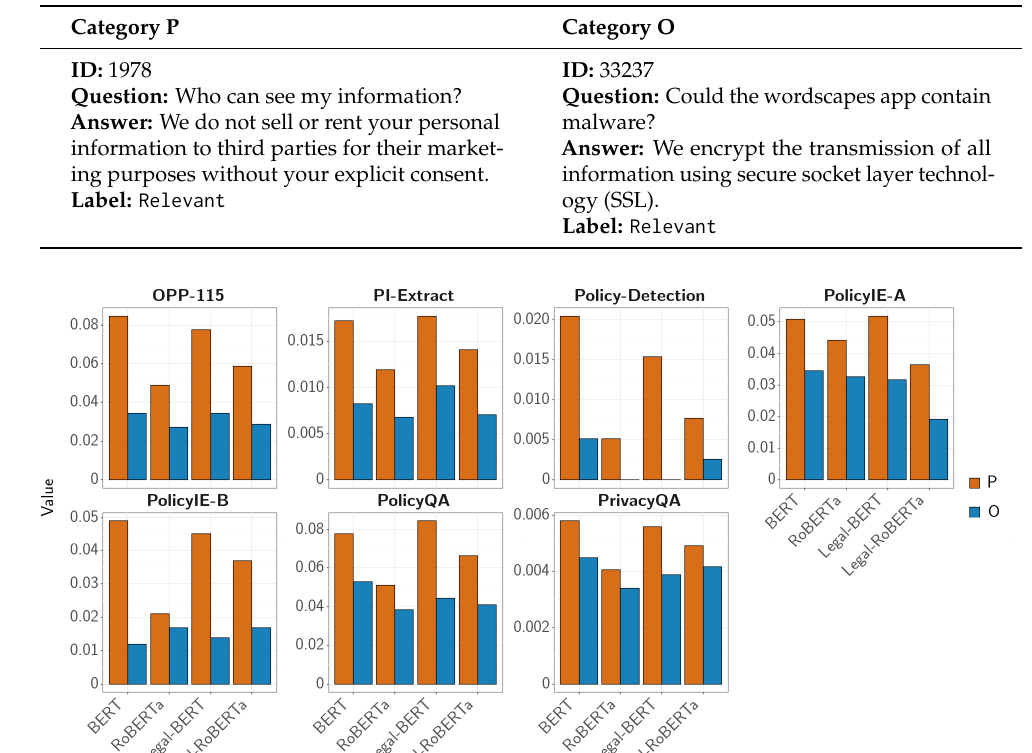
Table 4. Test-set examples from PrivacyQA that fall under categories P and O for PrivBERT vs. BERT.